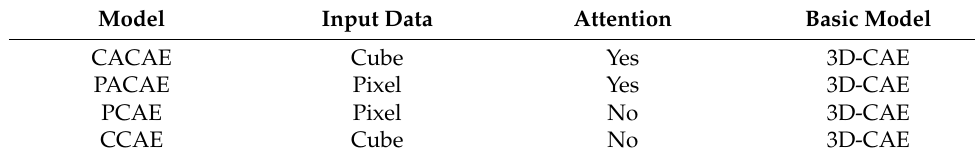
Table 2. Comparison table of the differences between all 3DCAE-based models. Model Attention